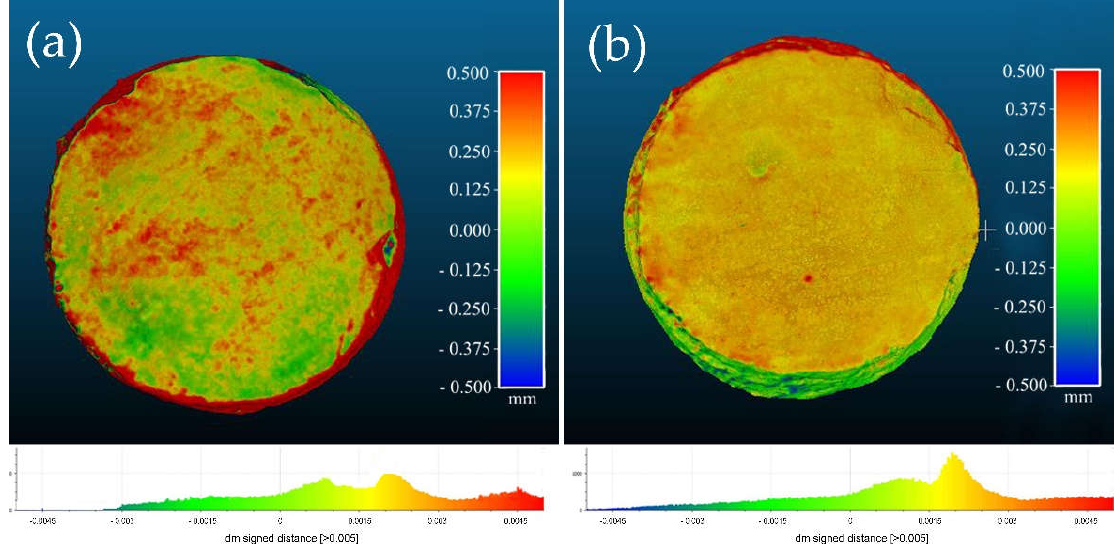
Figure 6. Rough quantification of the thickness of the whitish deposits eliminated in the specimens which has been carried out mechanical cleaning; the green areas were those in which the treatment has hardly been noticeable, and the yellow and red areas were those in which the treatment had been more appreciable: ( a ) M1; ( b ) M2.